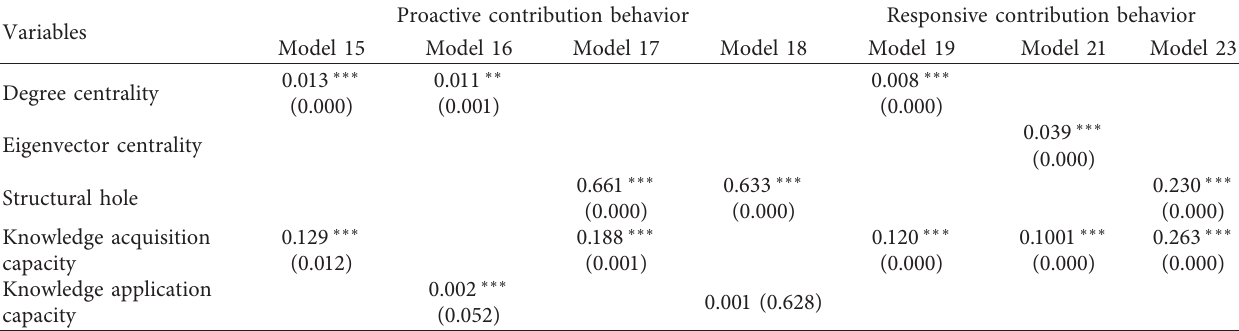
Table 8: The regression results of hypothesis